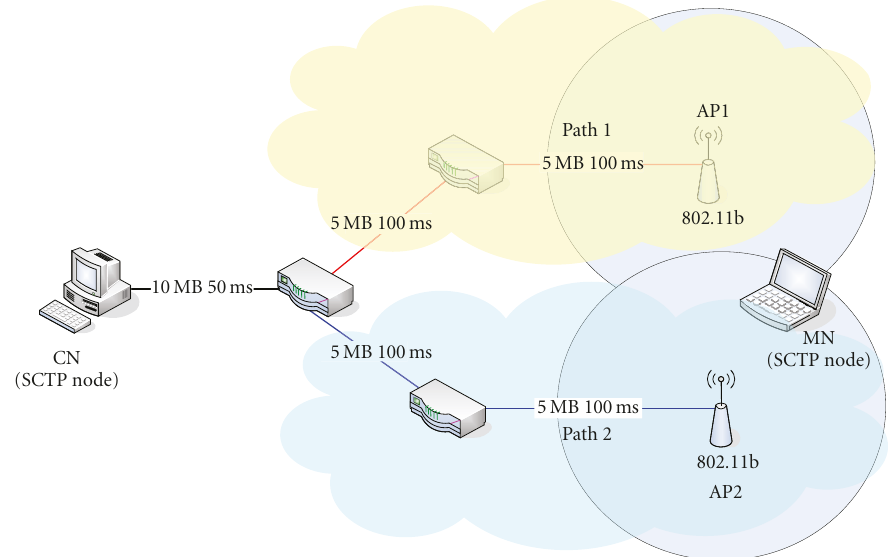
Figure 8: Quality-aware SCTP Path failure detection mechanism experiment topology.